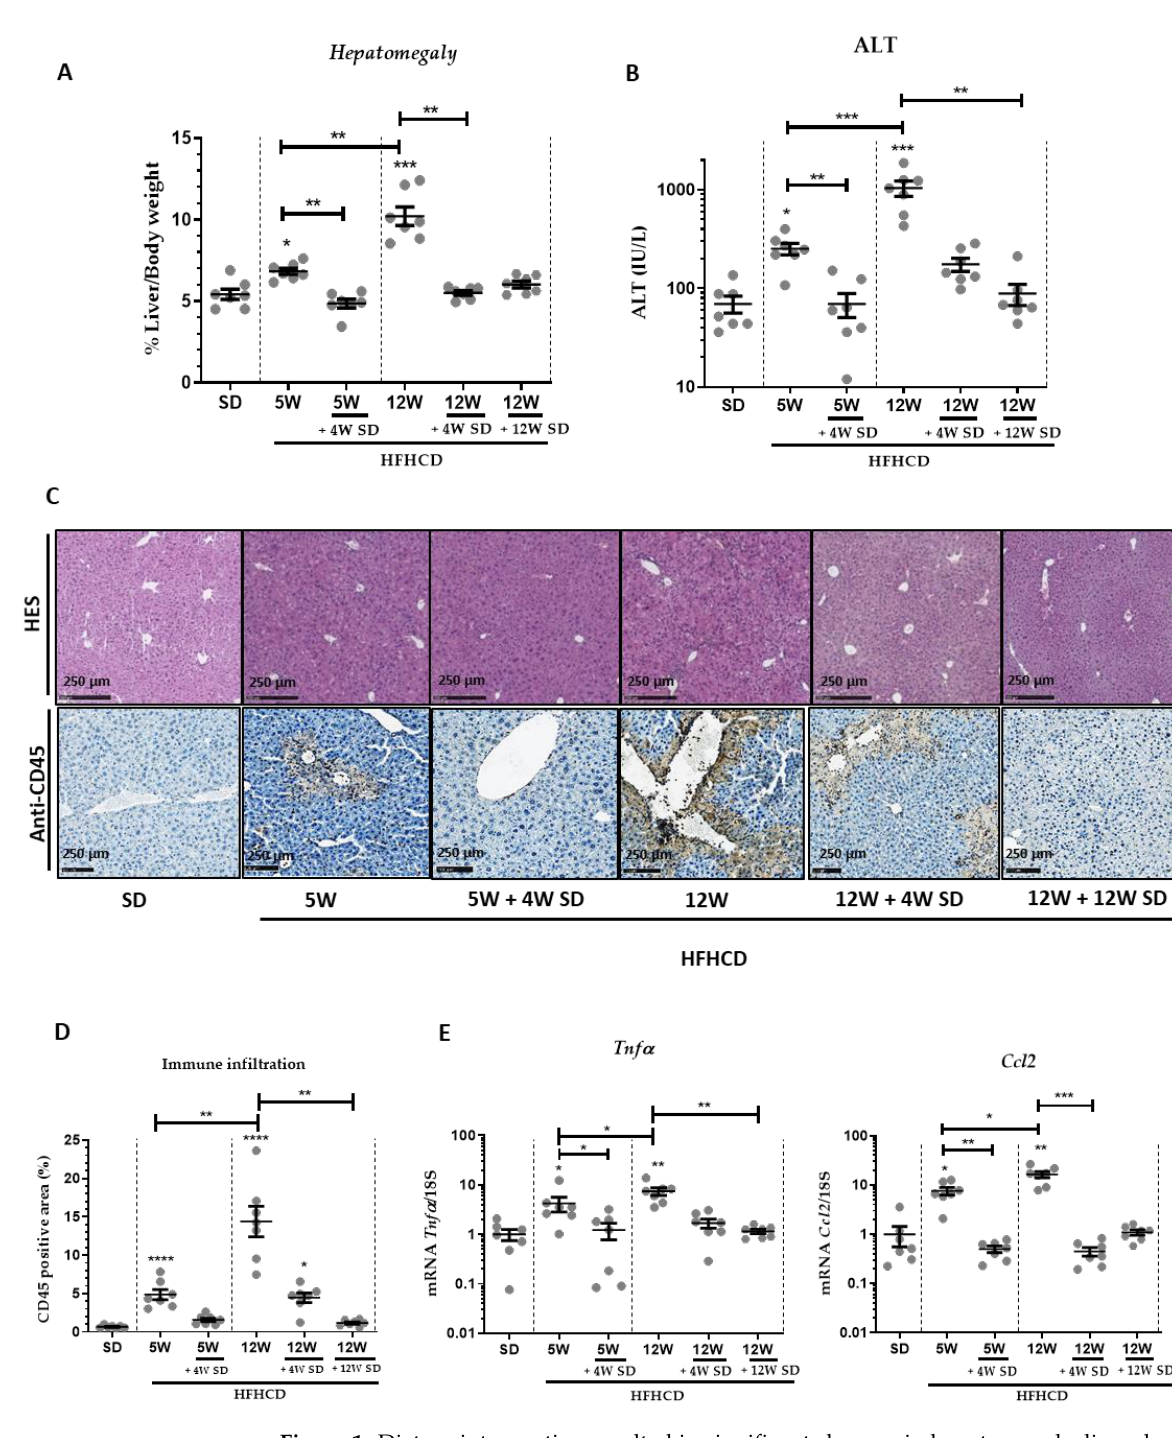
Figure 1. Dietary intervention resulted in significant changes in hepatomegaly, liver damage and inflammation. Six groups of seven male mice were given separate diet regimens of either a standard diet (SD) or a high-fat, high-cholesterol diet (HFHCD) for 5 or 12 weeks (W), with some groups returning to the SD on an additional period of 4 or 12 weeks. ( A ) Percentage of liver weight to body weight. ( B ) Level of ALT in plasma. ( C ) Hematoxylin and eosin (H&E; upper panels) and CD45 staining (lower panels) of liver sections. ( D ) Quantification of immune infiltrates measured from CD45 positive area. ( E ) Liver transcript expression of Tnf- α and Ccl2. For all graphs, each dot represents an individual, and error bars are expressed as means ± SEM (* p < 0.05, ** p < 0.01, *** p < 0.001 and **** p <